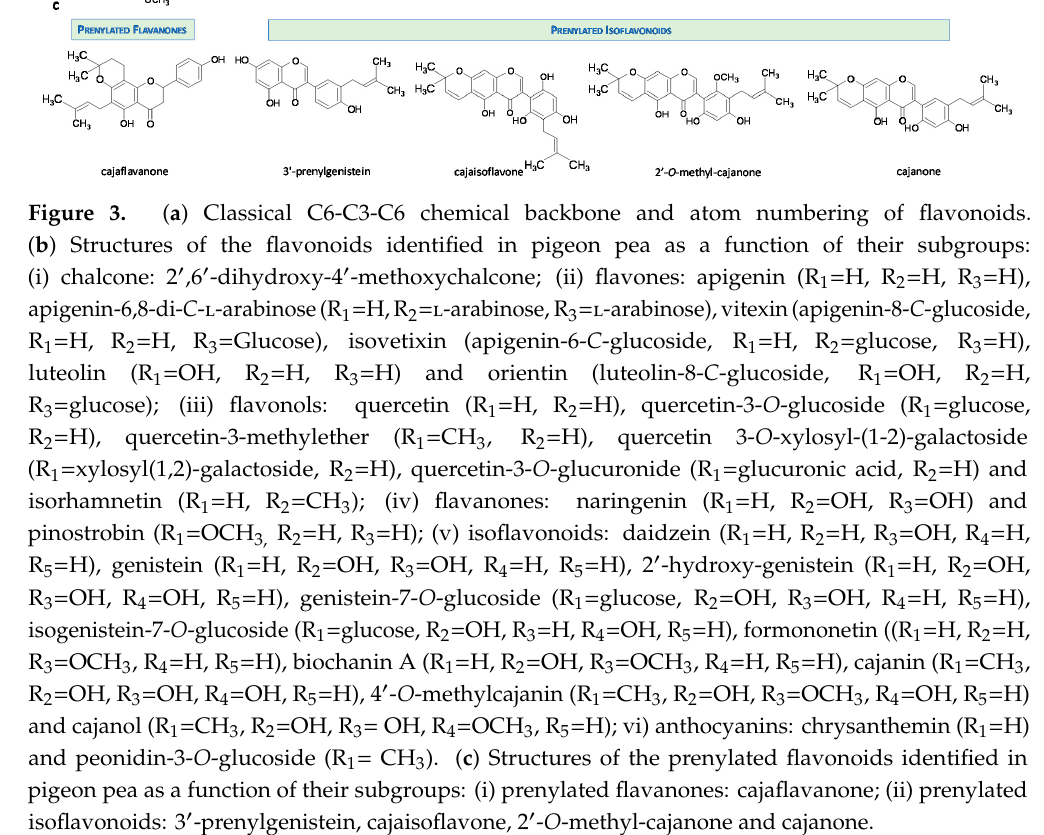
pigeon pea as a function of their subgroups: (i) prenylated flavanones: cajaflavanone; (ii) prenylated isoflavonoids: 3 (cid:48) -prenylgenistein, cajaisoflavone, 2 (cid:48) - O -methyl-cajanone and